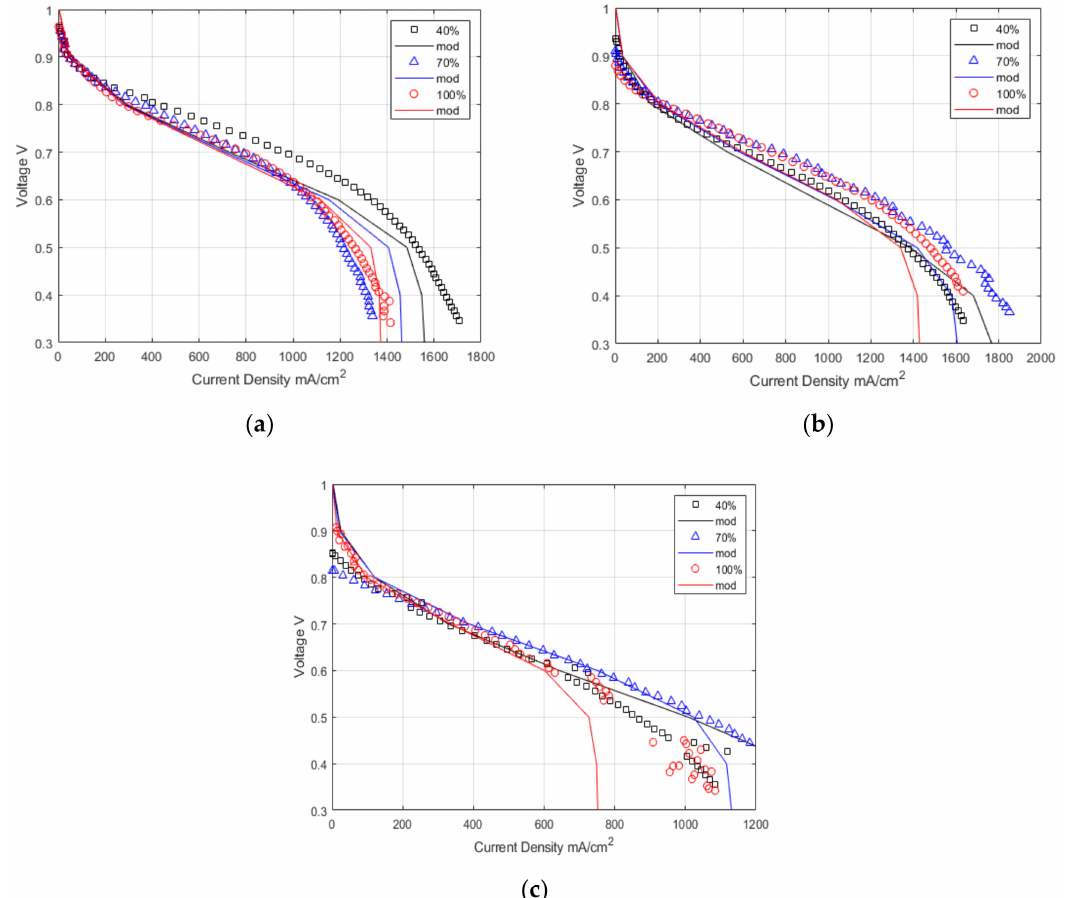
Figure 7. Experimental and modelling data for polarisation curves at ( a ) 80 ◦ C, ( b ) 100 ◦ C, ( c ) 120 ◦ C, and 40%, 70%, and 100% Relative